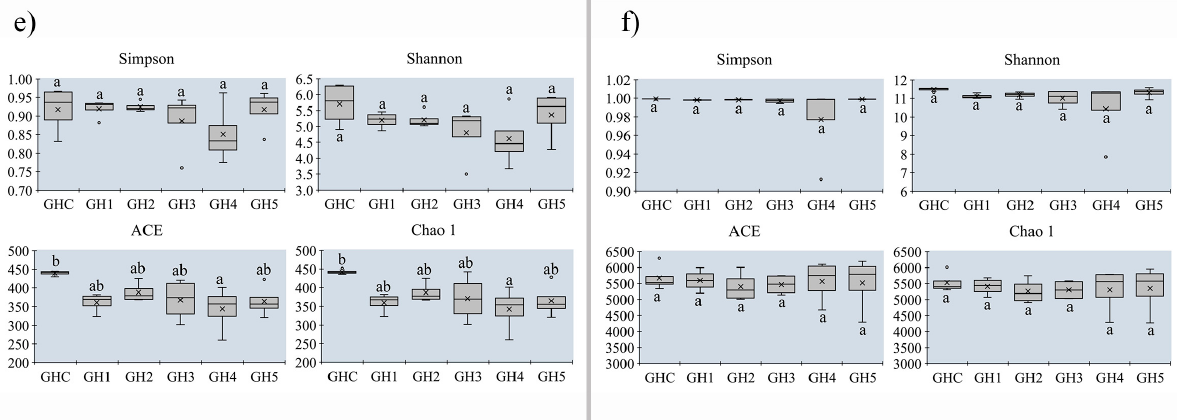
Figure 6. Alpha-diversity estimators of the soil fungal ( a , c , e ) and bacterial communities ( b , d , f ) of the investigated morel farms. For individual index boxes, different letters indicate significant differ- ences at p = 0.05 (ANOVA) between means (Tukey’s HSD pairwise comparisons, n =